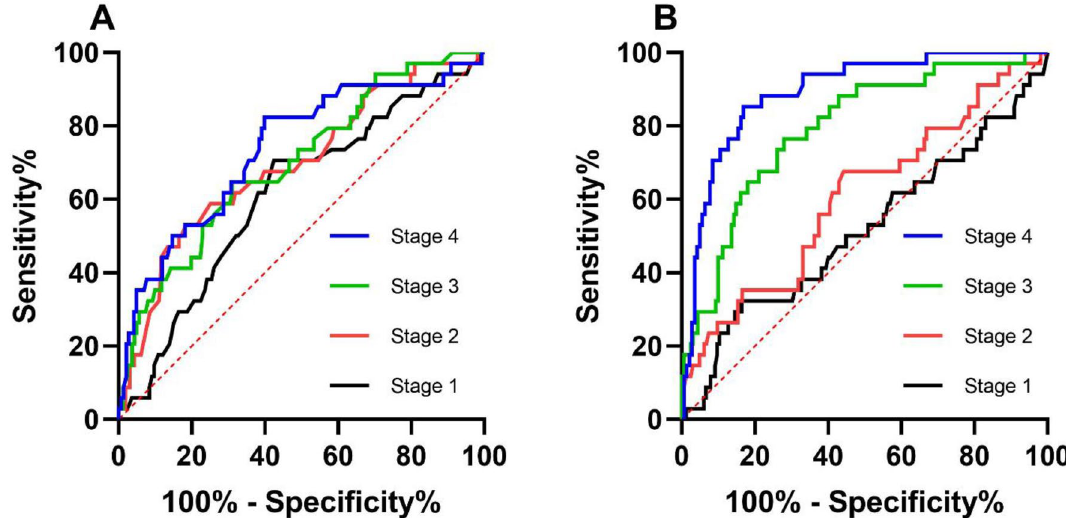
Figure 2. ROC curve of the albumin/prealbumin concentration for laparotomy in SAP. ( A ) The ROC curve of albumin, and ( B ) the ROC curve of